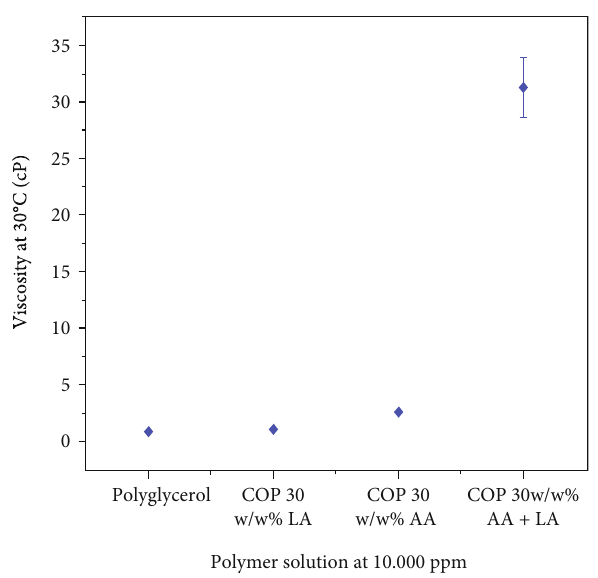
Figure 3: The viscosity of polymer solutions of 10.000ppm in distilled water at 30 ° C.